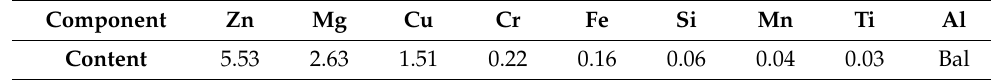
Table 1. Composition of 7075 Al alloy (wt.%).